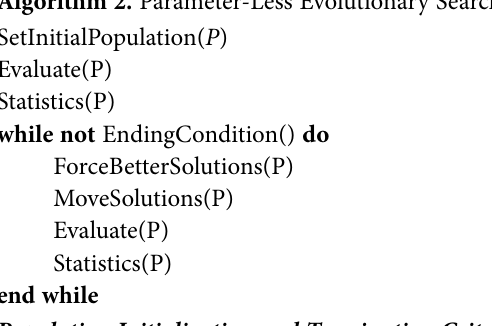
Algorithm 2. Parameter-Less Evolutionary Search: